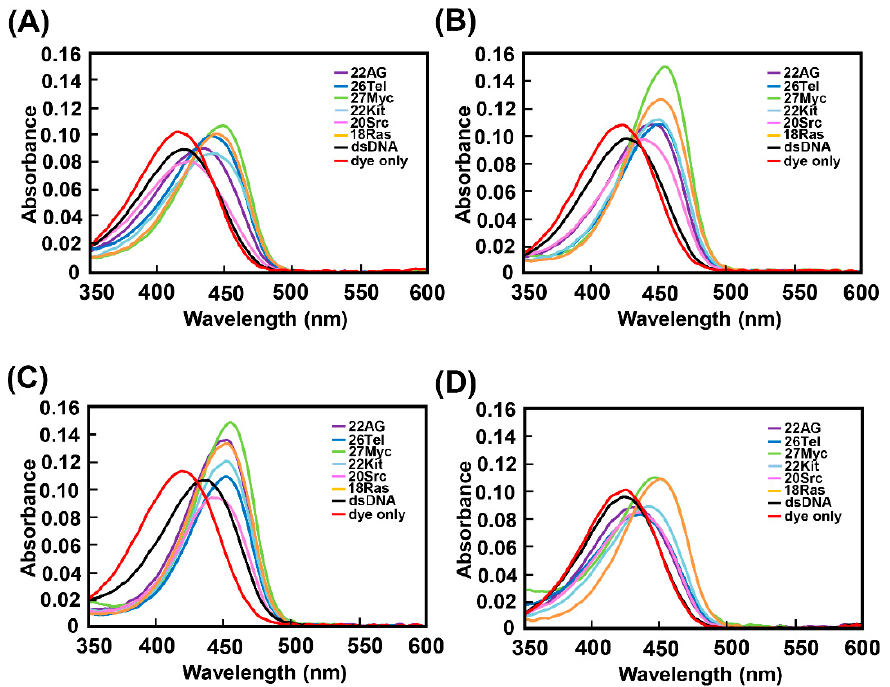
Figure 7. UV-Vis absorption spectra of ( A ) ThT-HE, ( B ) ThT-OE2, ( C ) ThT-SP, and ( D ) ThT-OE11 (3 µ M) with or without oligonucleotides (15 µ M) in PBS140KM. Oligonucleotides: 22AG (purple), 26Tel (blue), 27Myc (yellow green), 22Kit (light blue), 20Src (pink), 18Ras (yellow), dsDNA (black), and dye only (red).